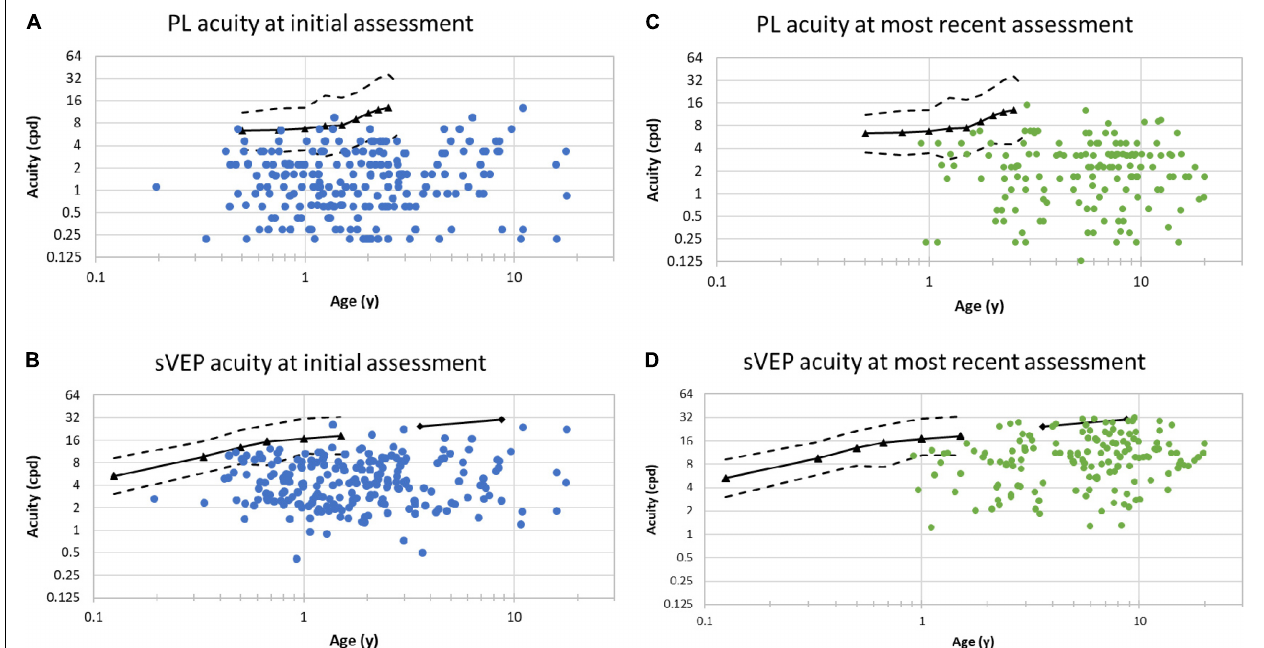
FIGURE 1 | Binocular visual acuities assessed by two different methods at two distinct time points. Acuity (ordinate) is on a log 2 scale and age (abscissa) is on a log 10 scale; cpd indicates cycles per degree. (A) Preferential looking acuities at first clinical visit. (B) Sweep visual evoked potential (sVEP) acuities at first clinical visit. (C) Preferential looking acuities at most recent clinical visit. (D) sVEP acuities at most recent clinical visit. (A,C) Mean normal preferential looking acuity (black triangles) and the 95% limits of normal acuity (dashed lines) based on published results in age matched controls (Leone et al., 2014). (B,D) Mean sVEP acuities in typically developing children (black triangles Birch, 2006 and diamonds Orel-Bixler, 1989) based on published findings; the dashed lines represent the 95% limits of normal